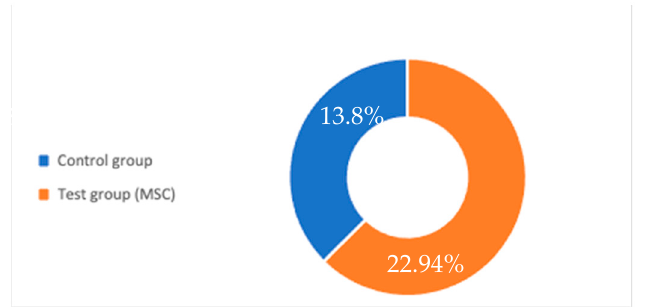
Figure 2. Comparative graphic between the control group and test group regarding new bone formation. MSC: Mesenchymal stem cell.